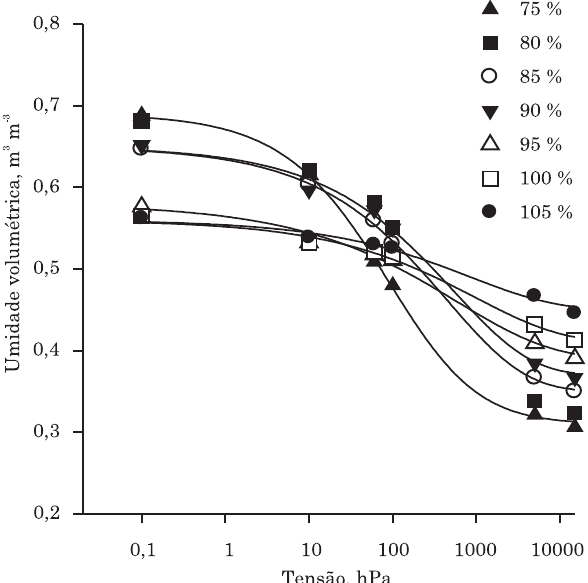
Figura 3. Curva de retenção de água nos diferentes graus de